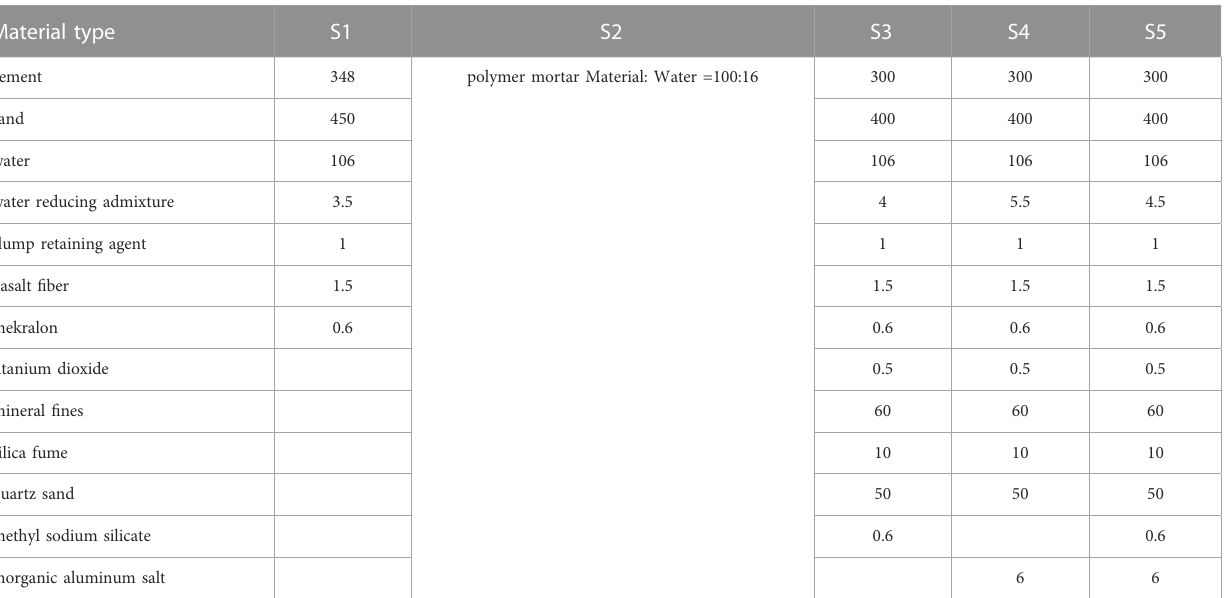
TABLE 2 Mortar mix ratio (unit: kg/m 3